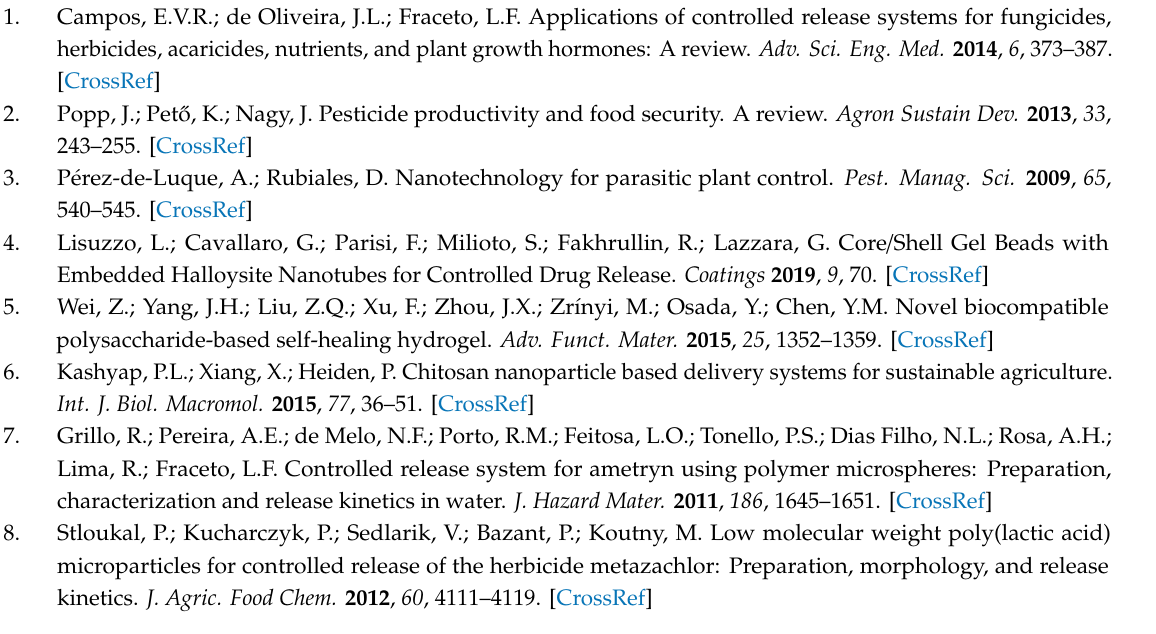
Figure S1: Calibration curve of herbicides solution